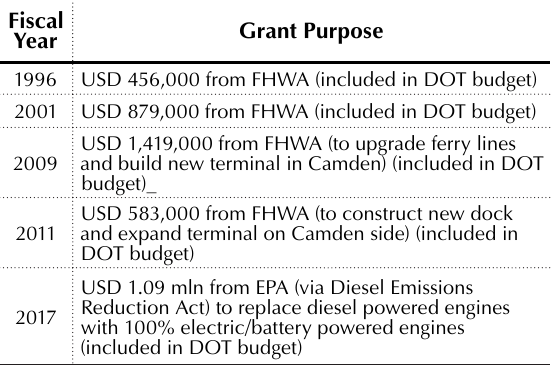
Table 2. Estimated Federal grants for the Gee’s Bend